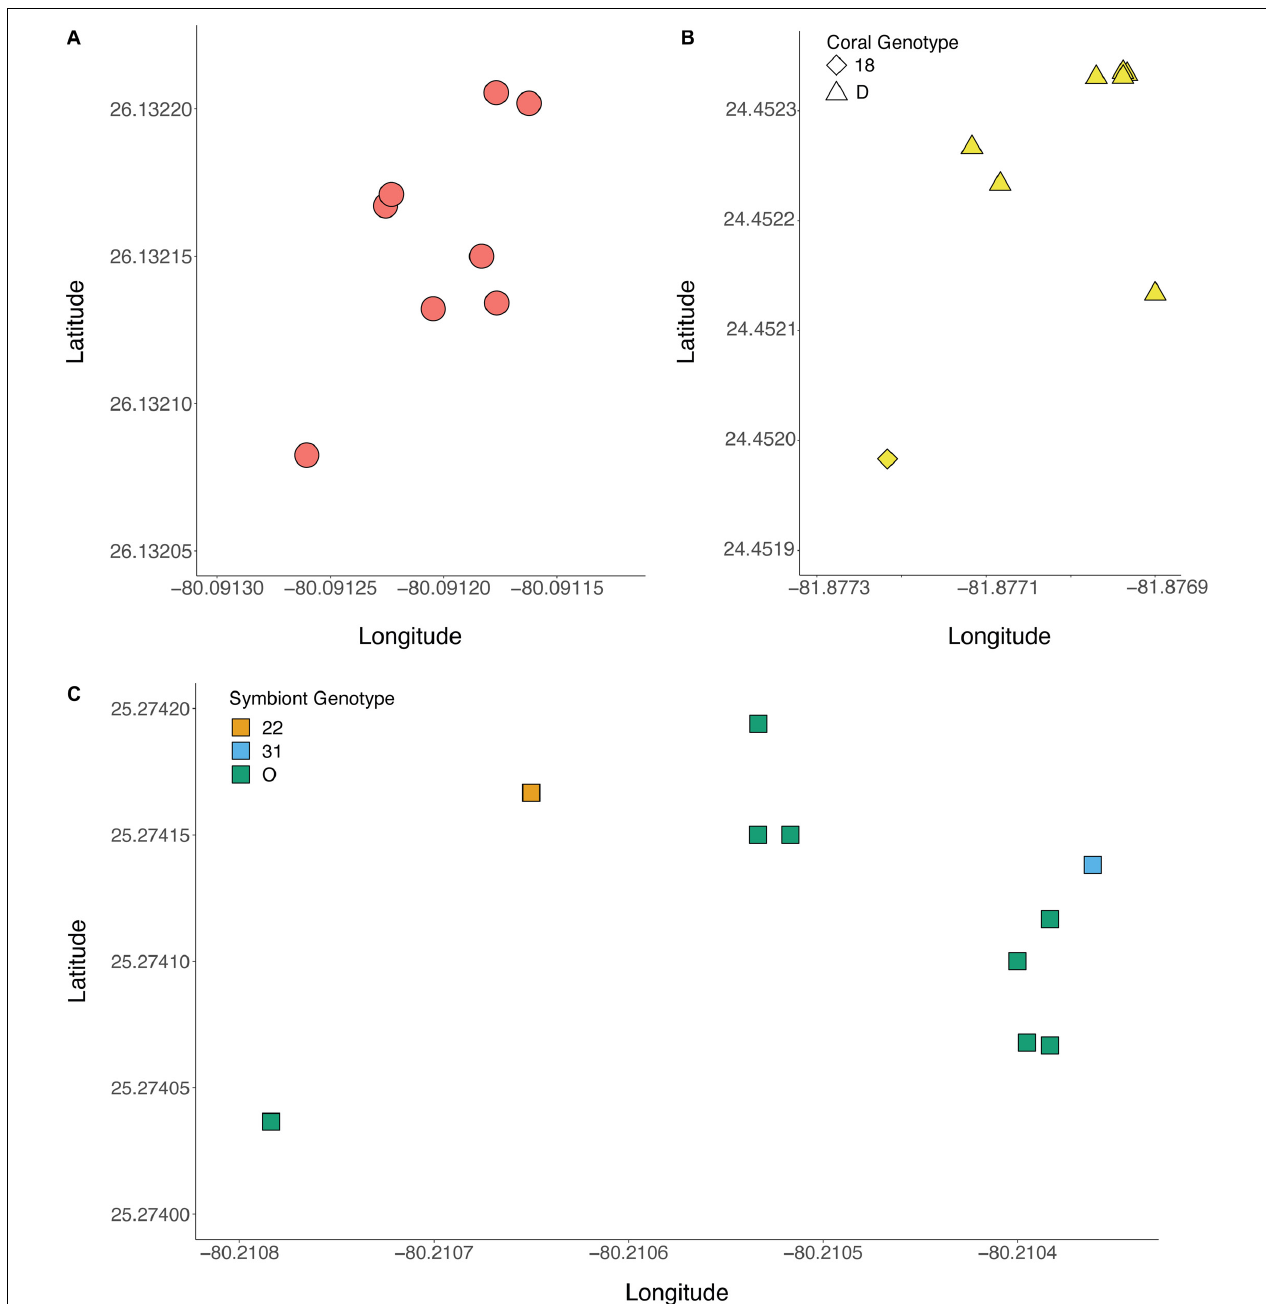
FIGURE 5 | Representative plots showing the spatial arrangement of genotyped colonies of D. cylindrus and associated strains of B. dendrogyrum . Within a site, most ramets of a coral genet associated with the same symbiont strain. (A) Pacific Mako Anchorage, a site in Broward County, (B) Sand Key Spa, a site in the Lower Keys, (C) Pillar Coral Forest, a site in the Upper Keys. The symbol shape corresponds to the coral genotype, and the color corresponds to the symbiont